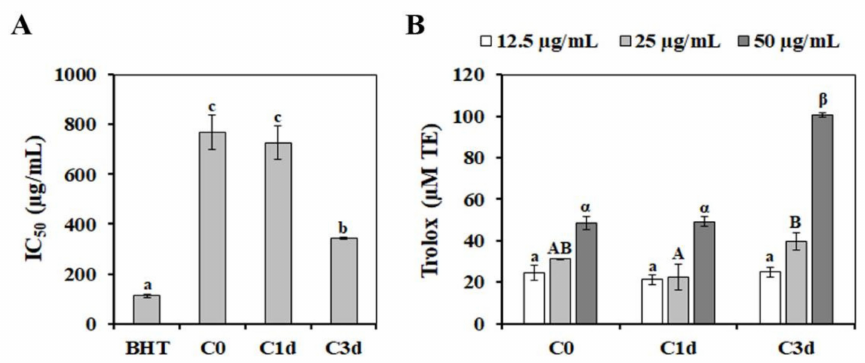
Figure 6. Chemical-based antioxidant activity was measured using the DPPH-radical-scavenging ( A ) and ORAC ( B ) assays. The DPPH-radical-scavenging activity and ORAC values are expressed as IC 50 and µ M of Trolox equivalents, respectively. The data are presented as mean ± SE of five independent experiments. Values with different letters are significantly different, according to Duncan’s multiple range test. C0, plants grown at 20 ◦ C (control plants); C1d and C3d, plants treated cold stress (10 ◦ C) for 1 day and 3 days, respectively.